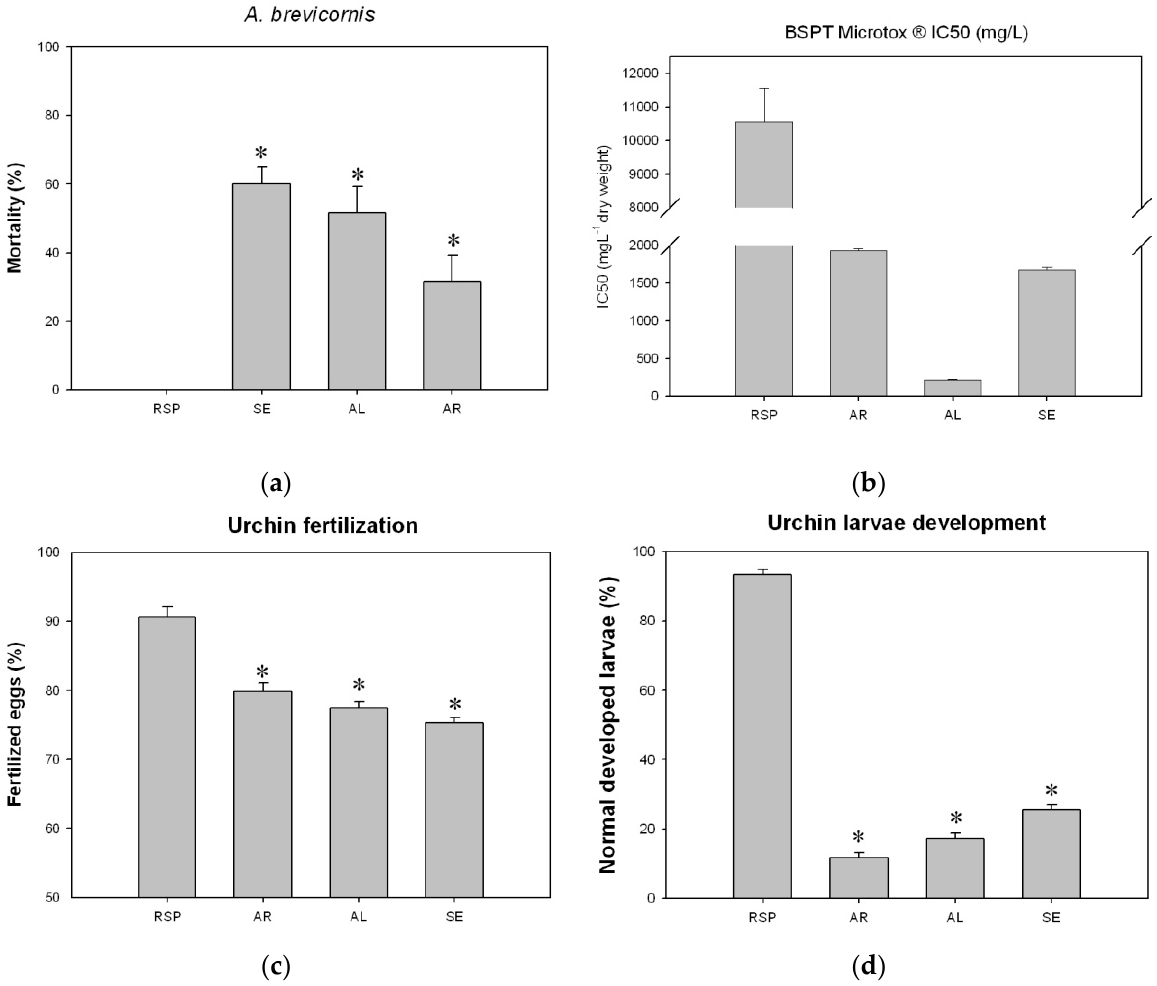
Figure 2. ( a ) A. brevicornis mortality (%) after 10 d exposure. ( b ) IC 50 results (mg L − 1 dw sediment) obtained from the BSPT Microtox ® samples. ( c ) Results of the P. lividus fertilization bioassay test: average percentage of fertilized eggs after exposure of the sperm to the sediment samples under laboratory conditions. ( d ) Results of the P. lividus embryo-larval bioassay test: average percentage of normal development of larvae after exposure of the fertilized eggs to the sediment samples under laboratory conditions. Asterisk (*) indicates significant differences ( p < 0.05) between samples and the control (RSP).